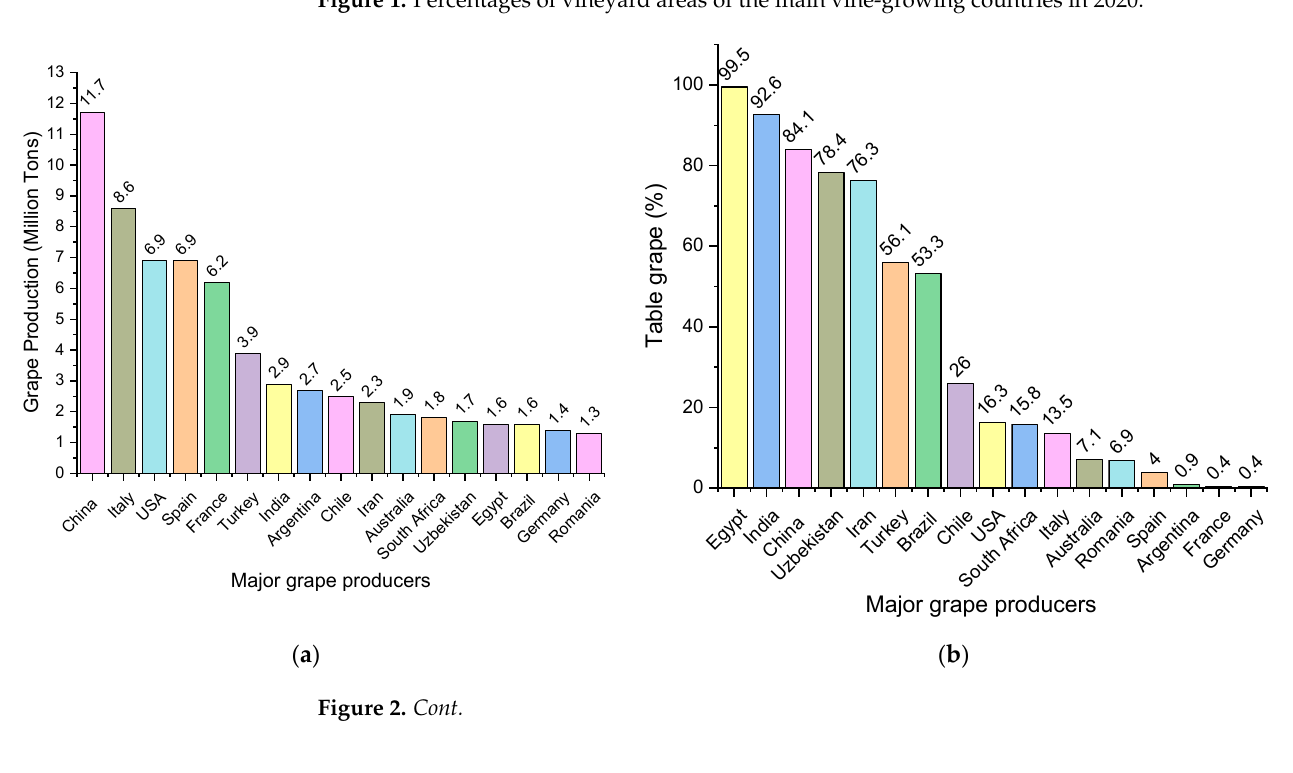
Figure 1. Percentages of vineyard areas of the main vine-growing countries in 2020.